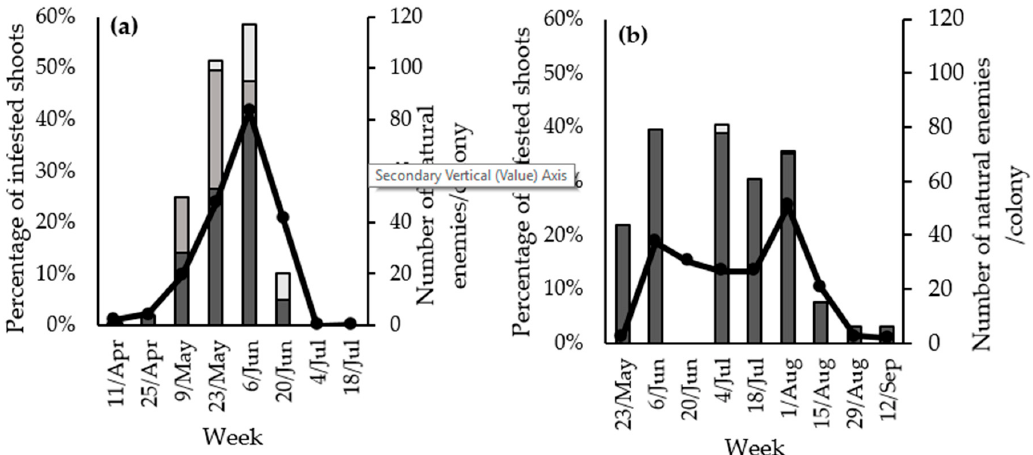
Figure 3. ( a ) Population dynamics of the RAA (black line) and their natural enemies per colony found in the colonies per week in 2016. Parasitoids (dark grey), Syrphidae (medium grey) and other predators (Miridae, Forficulidae, Araneae, Coccinellidae, Cecidomyiidae and Chrysopidae pooled together) (soft grey). ( b ) Population dynamics of the WAA (black line) and their natural enemies per colony found in the colonies per week in 2016: A. mali (dark grey) and other predators (Miridae and Coccinellidae pooled together) (soft grey). Primary axis shows percentage of shoots infested with RAA or WAA colonies. Secondary axis shows number of natural enemies per